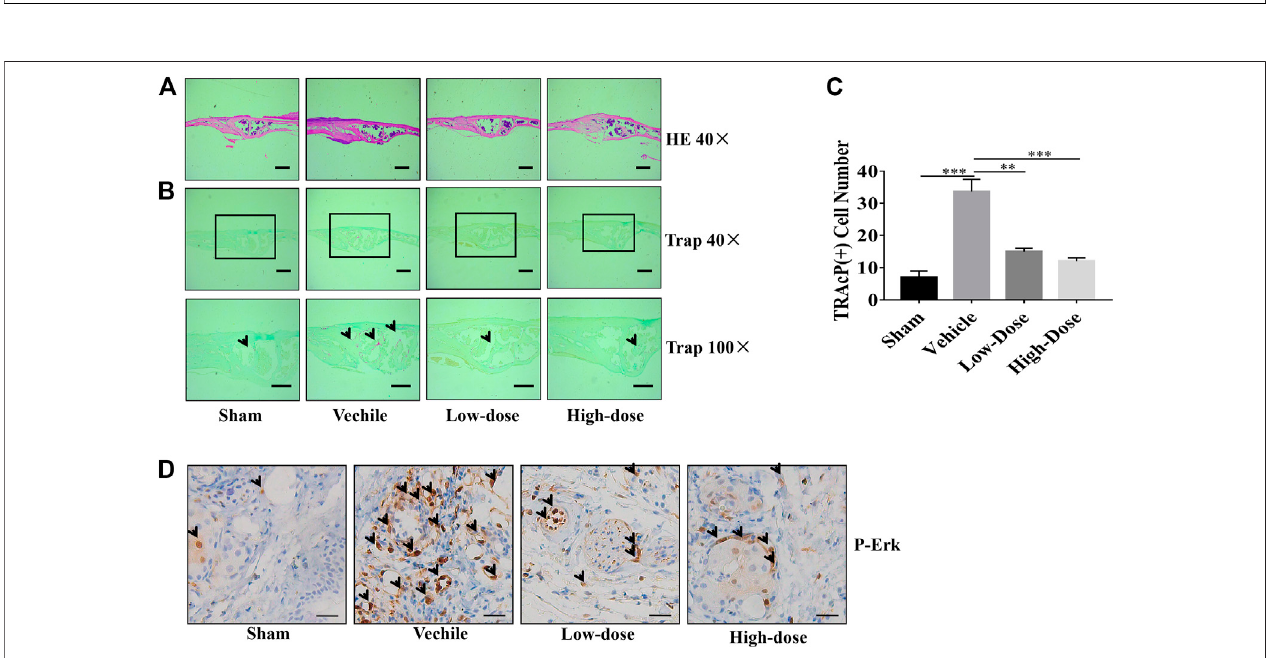
FIGURE7| Calvarialtissuesfromeachtreatmentgroupwere fi xed,decalci fi ed,dehydrated,andsectionedforanalysisbyH&EandTRAcPstaining.Representative images of calvaria stained with H&E (A) and TRAcP (B) , histological assessment of (C) , and numbers of TRAcP positive OC were shown. (D) Immunohistochemical staining of phosphorylated ERK in calvaria sections (scale bar = 500 µM) (** p < 0.01, *** p < 0.001).